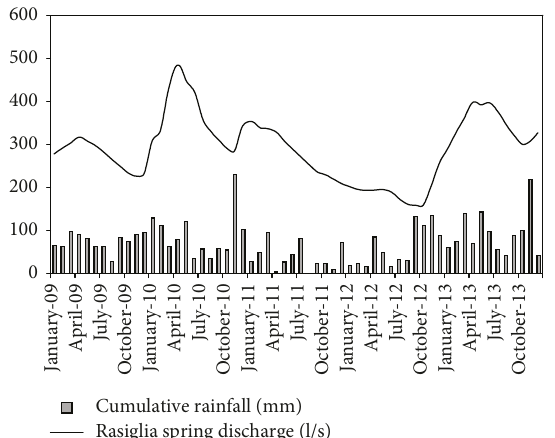
Figure 6: Time series of rainfall and spring discharge.